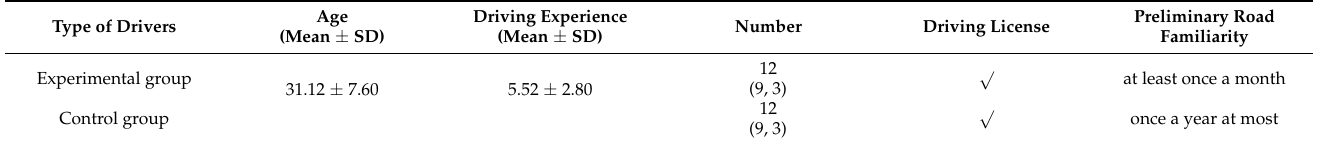
Table 1. The relevant information of the